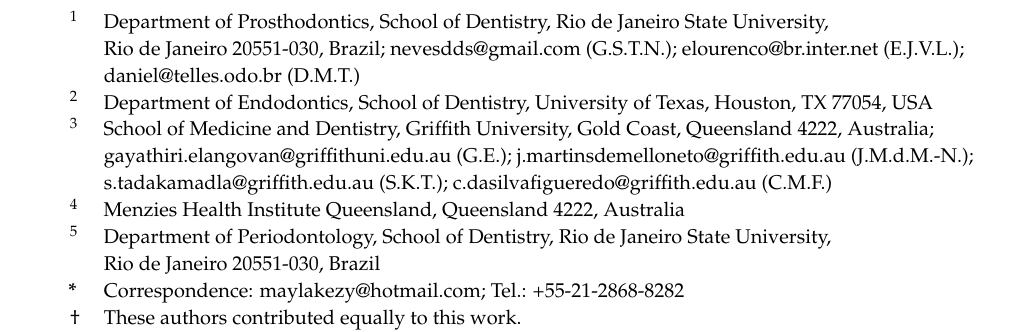
Figueredo, C.M. Peri-Implant Surgical Treatment Downregulates the Expression of sTREM-1 and MMP-8 in Patients with Peri-Implantitis: A Prospective